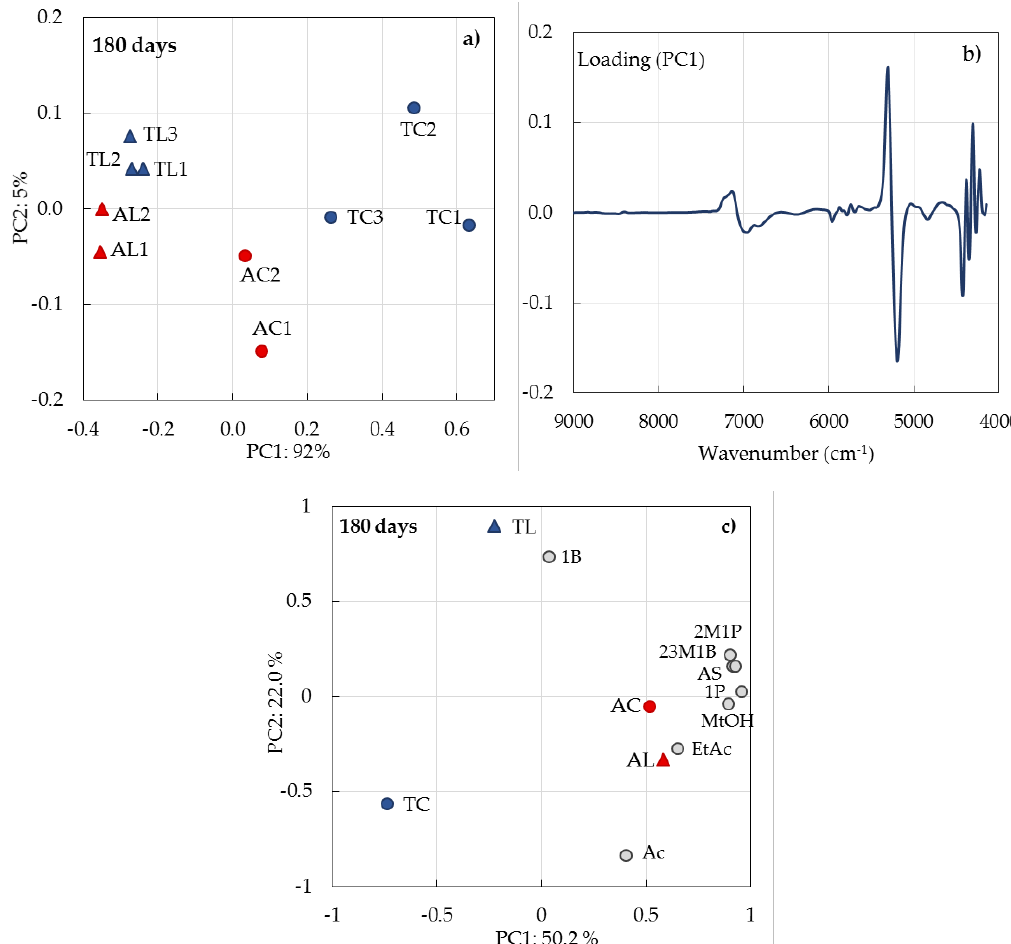
Figure 4. Principal component analysis of wine spirit aged by the traditional and alternative technologies with chestnut and oak wood during 180 days for: ( a ) scores of NIR spectral information; ( b ) loadings of NIR spectral information; ( c ) standardised scores and loadings of analytical parameters measured. TC—aged in 250 L chestnut new barrels; TL—aged in 250 L oak new barrels; AC—aged in 1000 L stainless steel tanks with chestnut wood staves and micro-oxygenation; AL—aged in 1000 L stainless steel tanks with oak wood staves and micro-oxygenation. AS—alcohol strength (%); MtOH—methanol (g/mL); Ac—acetaldehyde (mg/mL); EtAc—ethyl acetate (mg/mL);